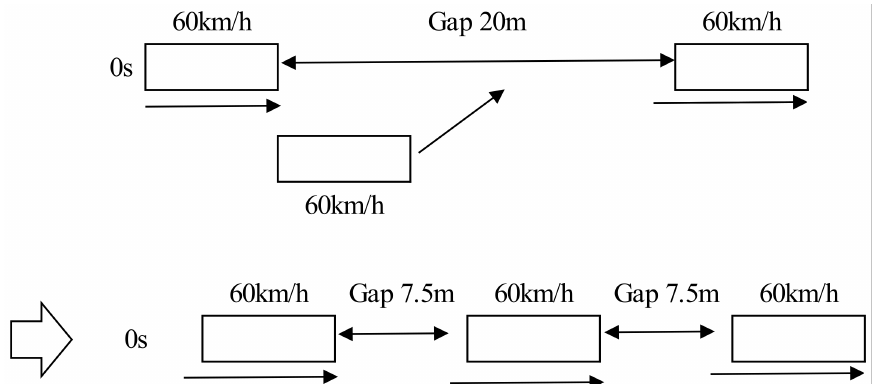
Figure 4. Representation of the cutting off behaviour (example case).